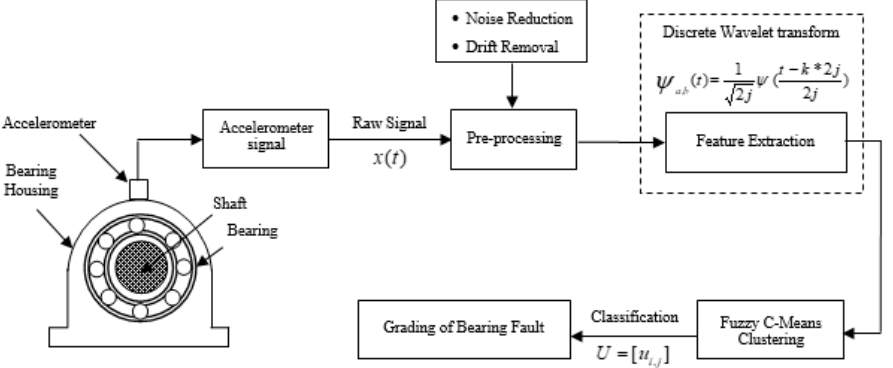
Figure 4. Schematic diagram of the proposed method for bearing fault classification.